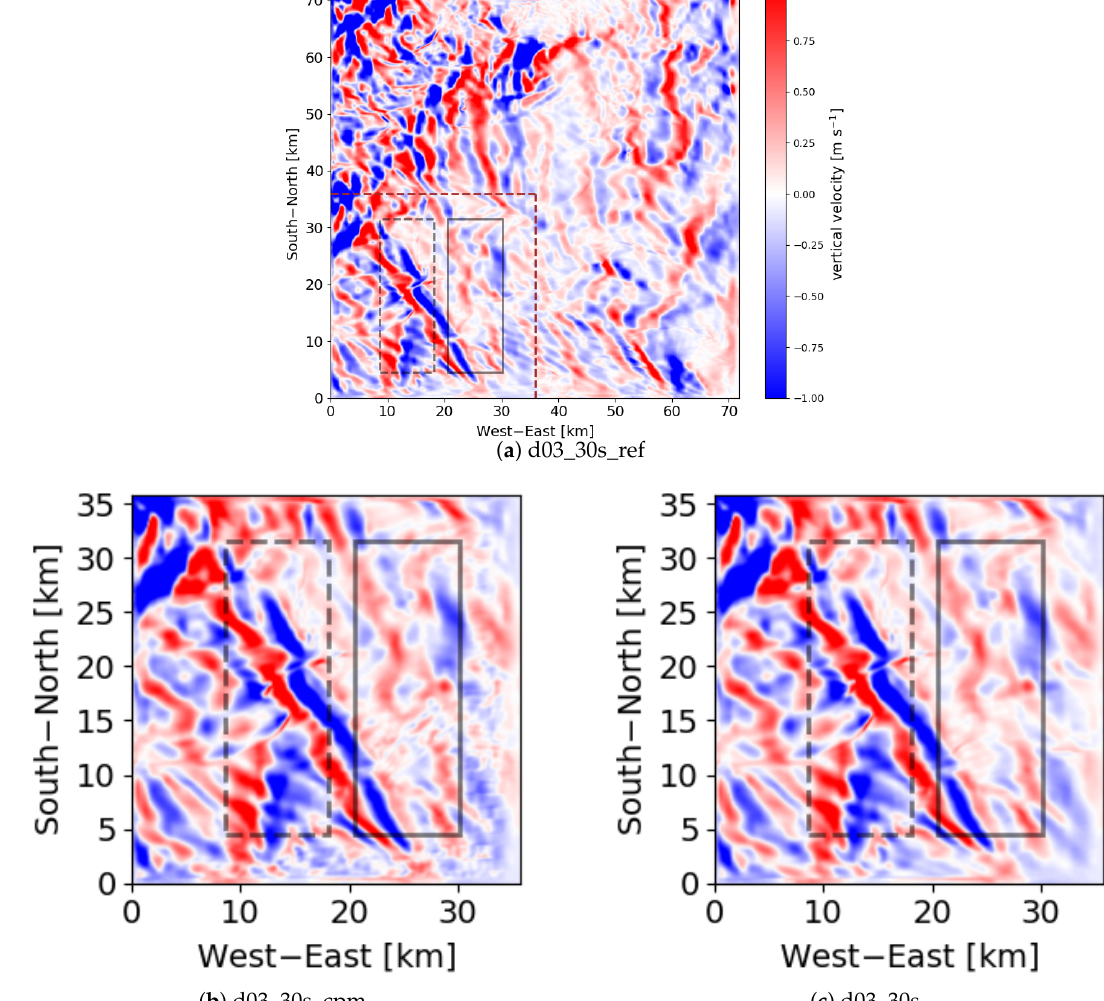
Figure 16. As in Figure 9 but at 2315 UTC 21 May 2017.